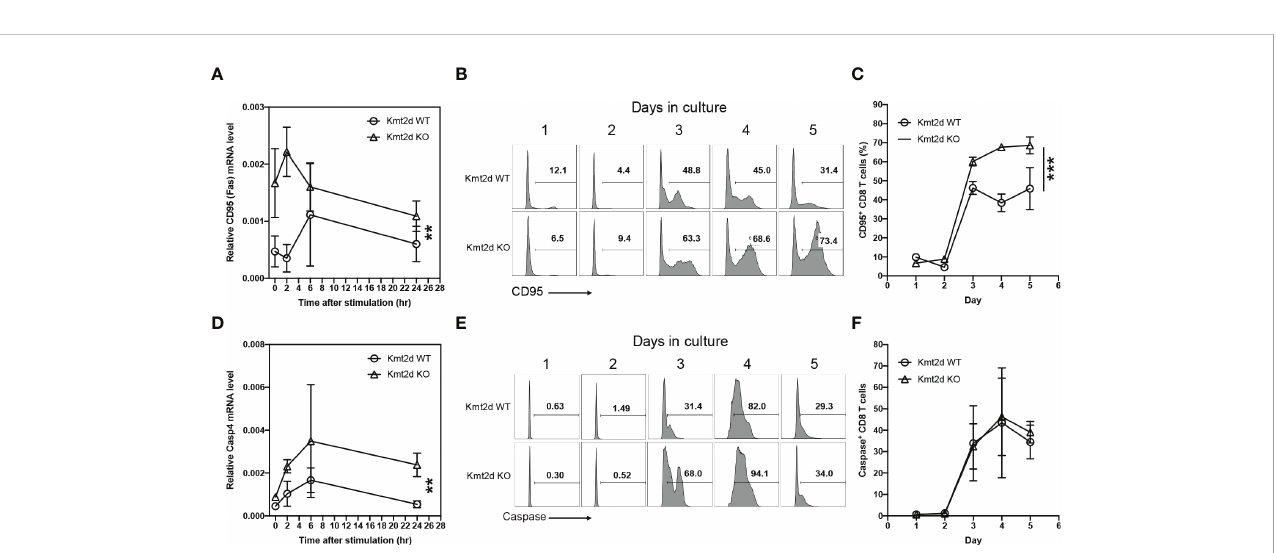
FIGURE 3 Increased apoptotic genes expression and caspase activated naïve CD8+ T cells of Kmt2d KO mice. (A) mRNA expression of Cd95 in naïve CD8+ T cells from Kmt2d WT and KO mice post one day stimulation with aCD3/CD28. (B) Representative histogram of CD95+ naïve CD8+ T cells after aCD3/CD28 stimulation. (C) Average percentage of CD95+ naïve CD8+ T cells after aCD3/CD28 stimulation from Kmt2d WT and KO mice (N=3). (D) mRNA expression of Casp4 in naïve CD8+ T cells post aCD3/CD28 stimulation. (E) Representative histogram of caspase activity at indicated time points. DEVDase activity was assessed using DEVD substrate-based assay. (F) Average of the caspase activity positive cells in percentage of total stimulated naïve CD8+ T cells (N=3). *p < 0.05; **p < 0.01 based on two-way Anova test.